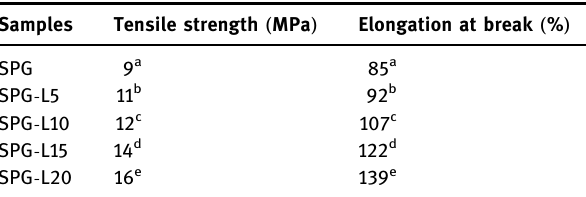
Table 2: The e ff ect of ε - polylysine concentration on the tensile strength and elongation at break Samples